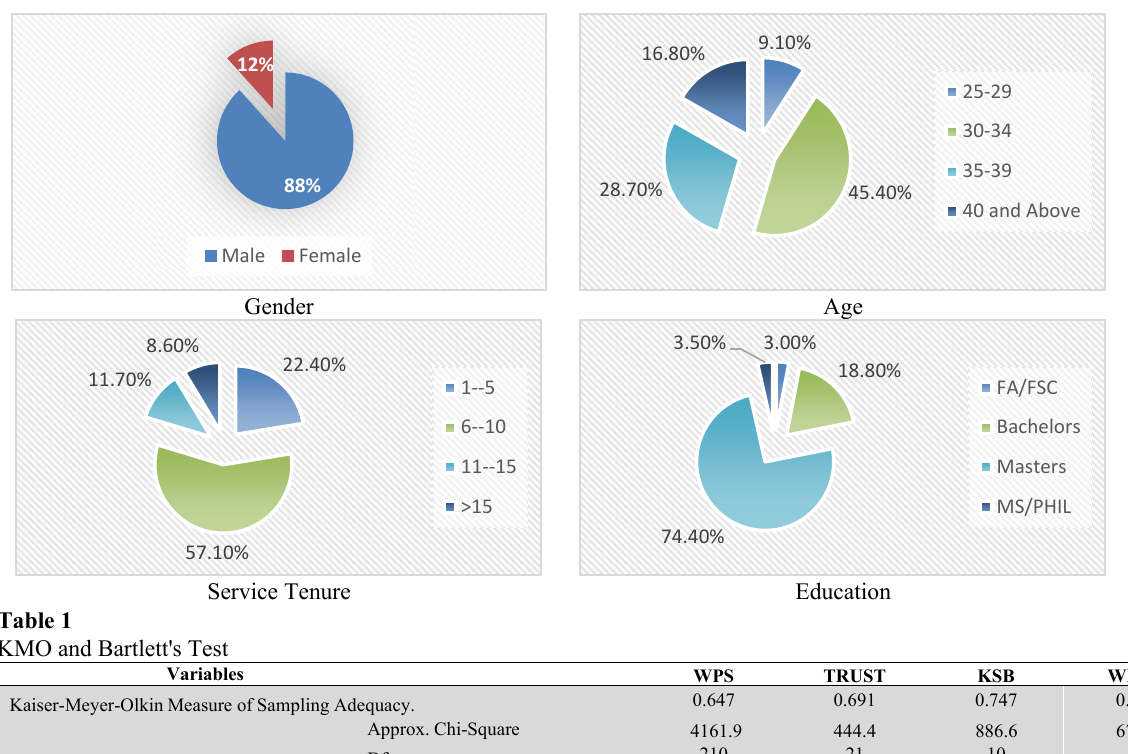
KMO and Bartlett's Test Variables WPS TRUST KSB WENG Kaiser-Meyer-Olkin Measure of Sampling Adequacy. 0.647 0.691 0.747 0.710 Approx. Chi-Square Bartlett's Test of Sphericity .000 .000 .000